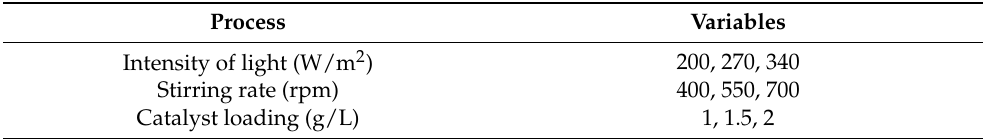
Table 8. Three different variables used in the